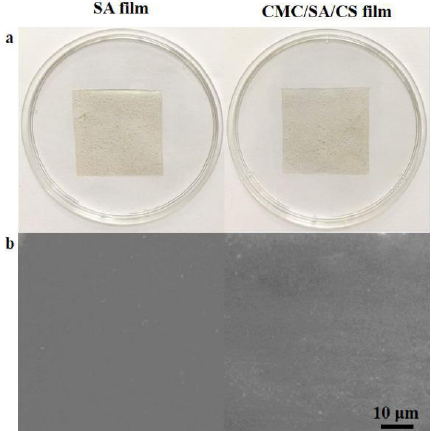
Figure 1. ( a ) Digital image of SA film and CMC/SA/CS film; ( b ) SEM images of SA film and CMC/SA/CS film.